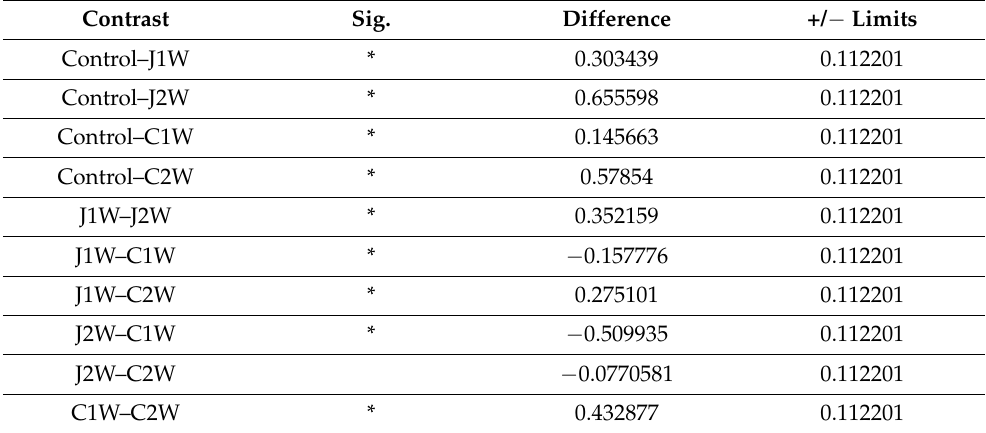
Table 4. Statistically significant differences in entropy between groups (* denotes a statistically